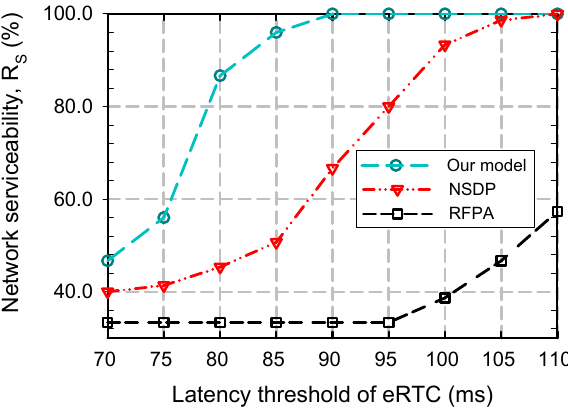
Figure 10. Serviceability comparison among the proposed model, NSDP and